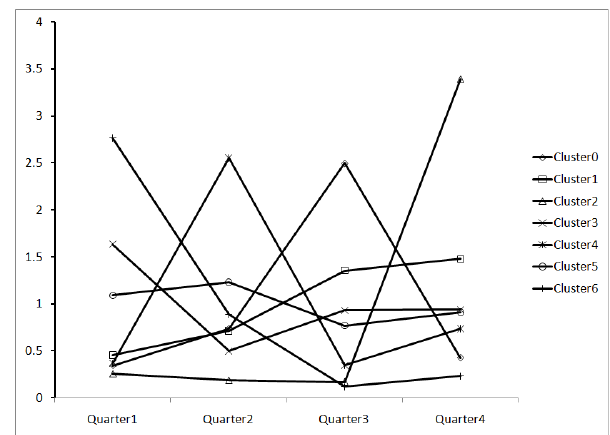
Figure 1. Tier-1 seasonality analysis – 2006 quarterly sales trend.